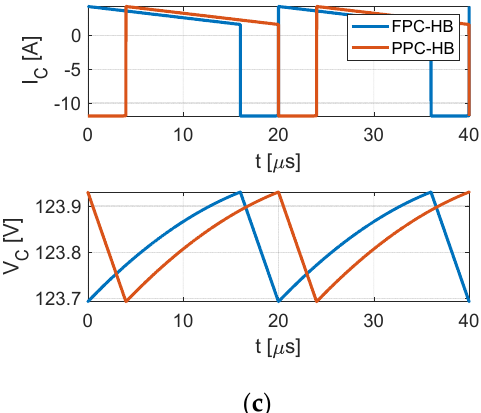
Figure 4. Current and voltage steady-state waveforms at the single-inductor topology ( a ) inductor, ( b ) semiconductor, and ( c ) capacitor.